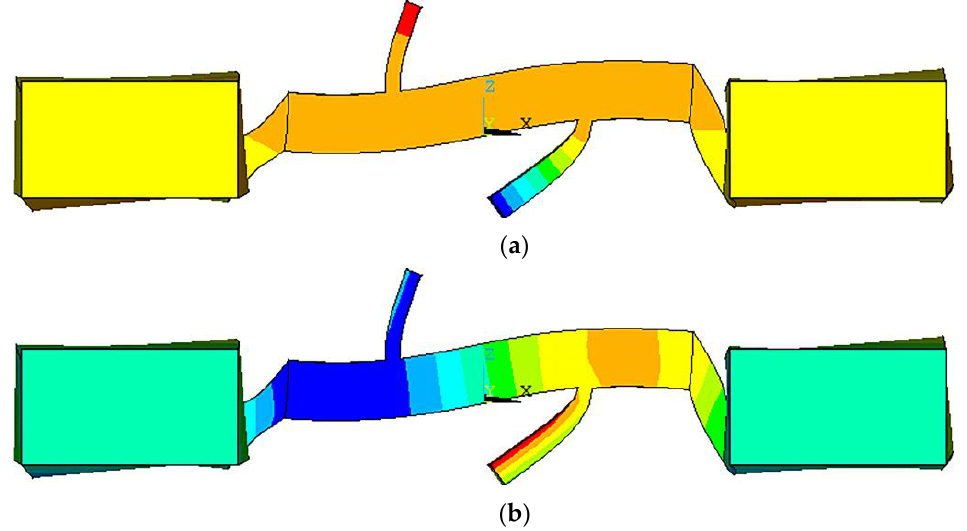
Figure 6. Model analysis: ( a ) X-directional vibration mode with aluminum bars for ends fixing; ( b ) Z-directional vibration mode with aluminum bars for ends fixing.